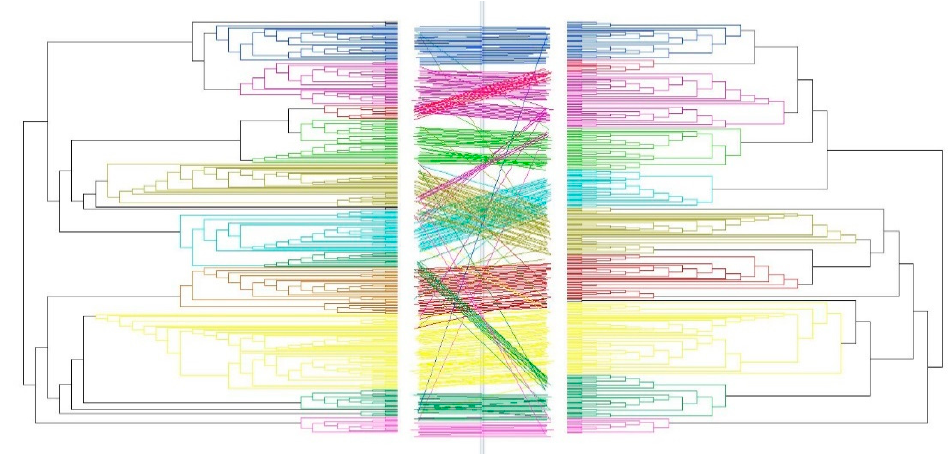
Figure 7. Dendrogram for 329 representative inbred lines based on 200 ( the right ) and 60 K SNPs ( the left ).